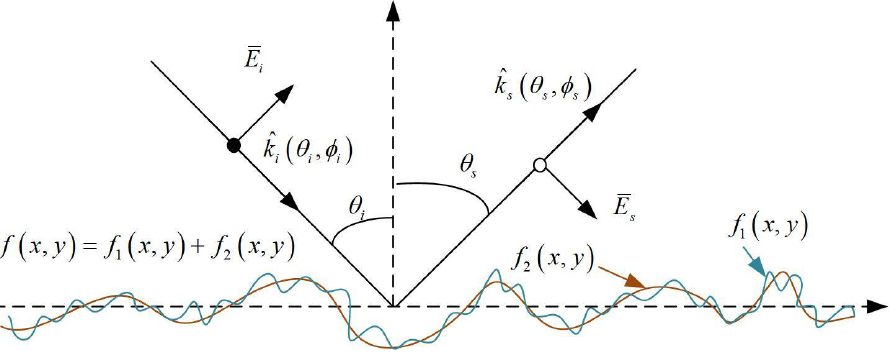
Figure 16. Wave scattering from a rough surface with two roughness